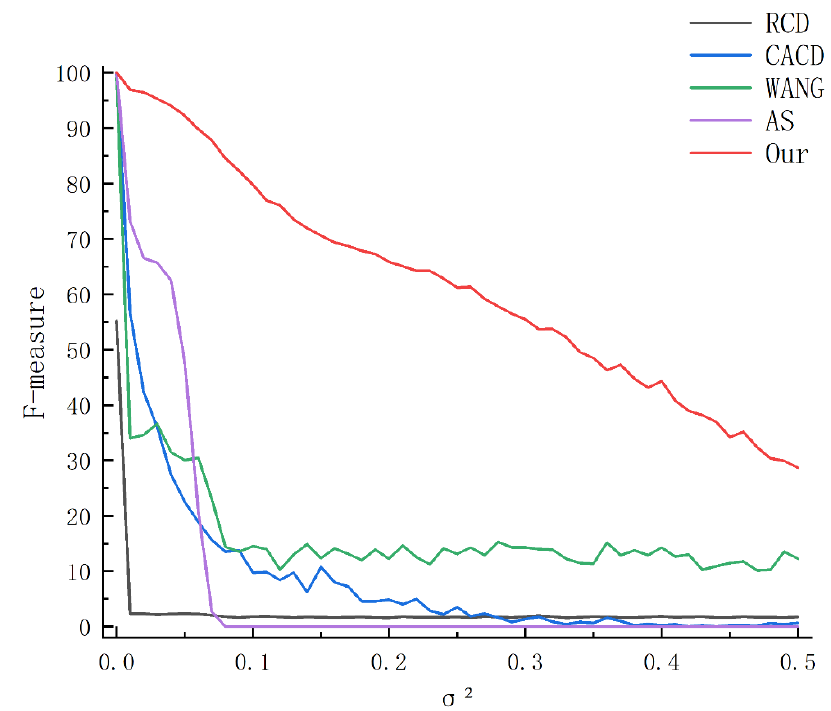
Figure 5. The F-measure results of five algorithms under different levels of Gaussian